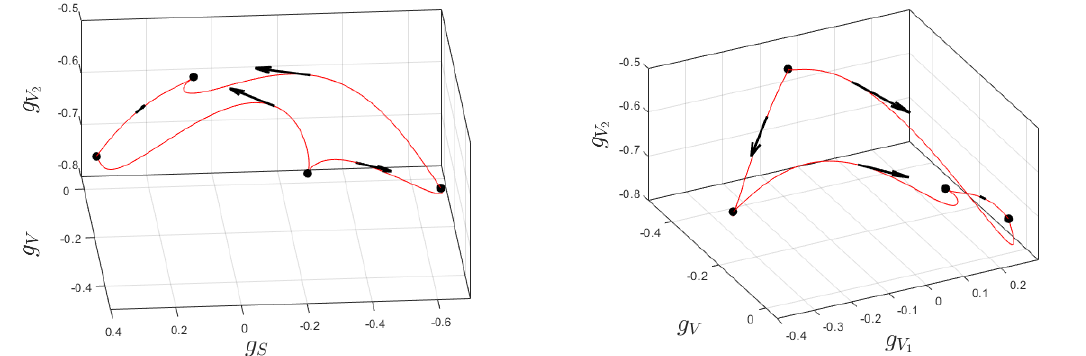
Figure 13. Fixed points and critical heteroclinic orbits of the QCD (3 ; 12) and (cid:11) g = (cid:11) nt . Left: projection on the ( g S ; g V ; g V g ( g V ; g V ; g V )-space. 1 2